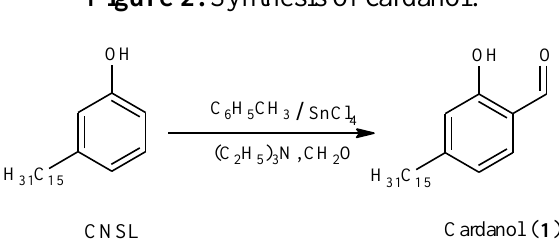
Figure 2. Synthesis of